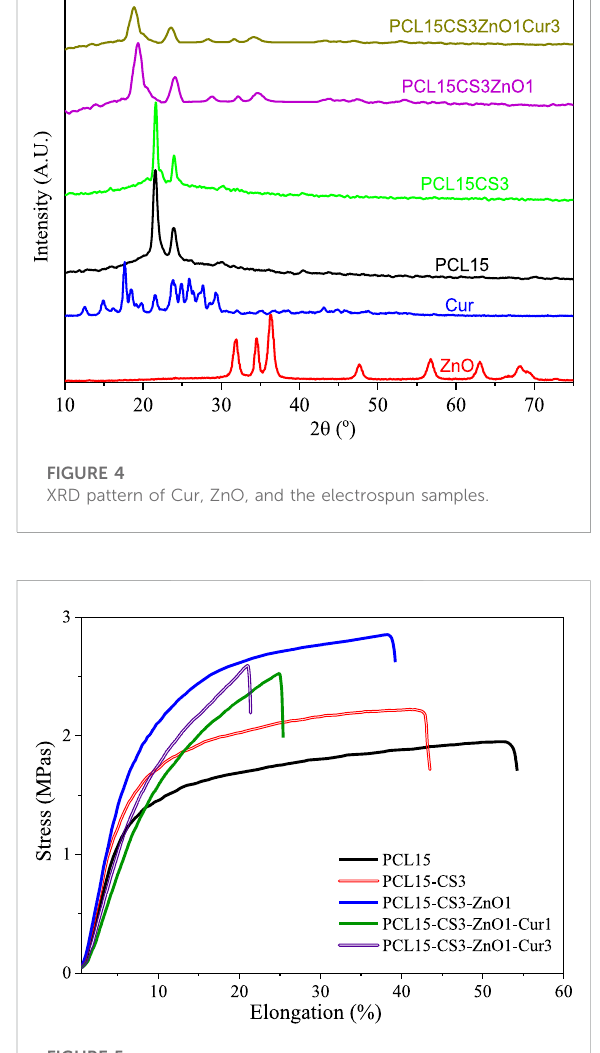
FIGURE 5 Stress-strain diagram of the electrospun nano fi bers.